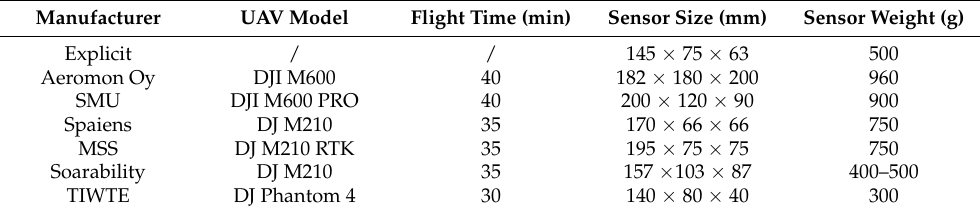
Figure 5. Comparison of different ship exhaust sniffing UAVs. Table 2. Comparison of parameters of different ship exhaust sniffing UAV.